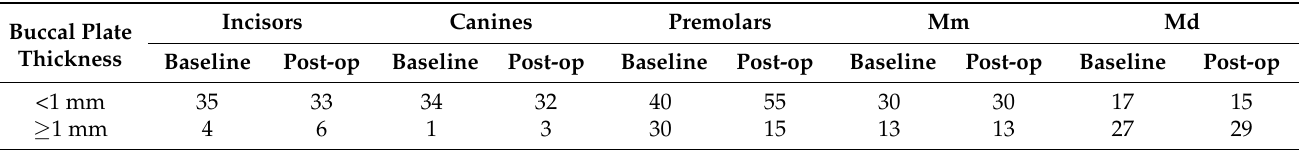
Table 2. Root distribution depending on the thickness of the buccal bone plate at the most coronal measurement point (0.5 mm from the crest) before and after orthodontic treatment (Mm, mesial root of molar; Md, distal root of molar). Incisors Buccal Plate Thickness ≥ 1